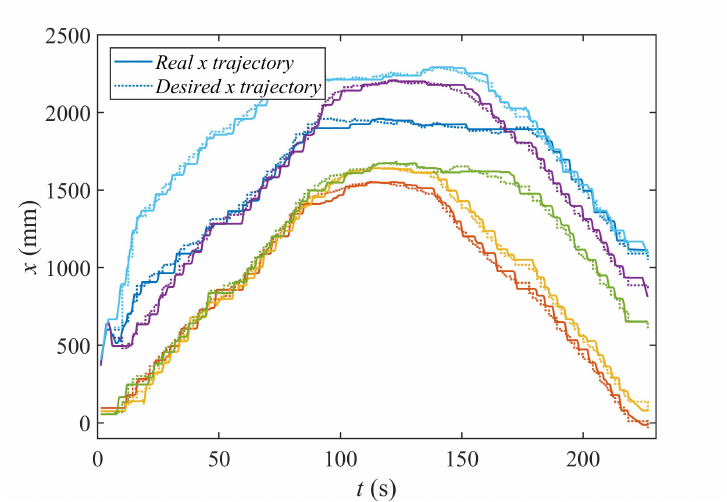
Figure 22. T-X representation of the consecutive goal positions and the real trajectories of the